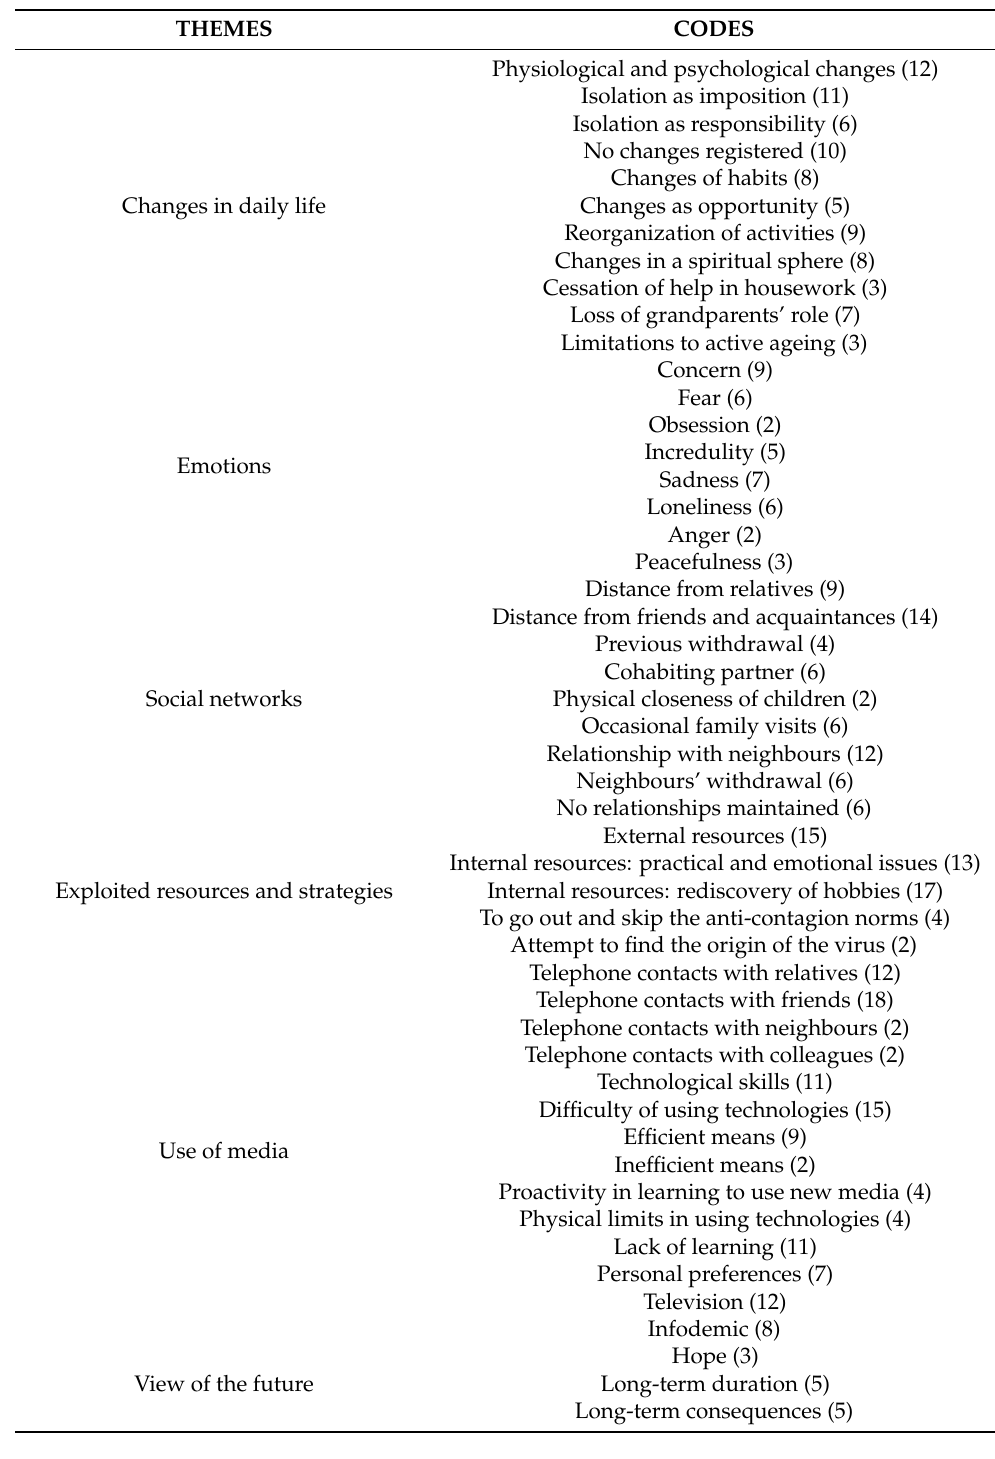
Table 1. Themes and codes with the number of interviews where each code was found in